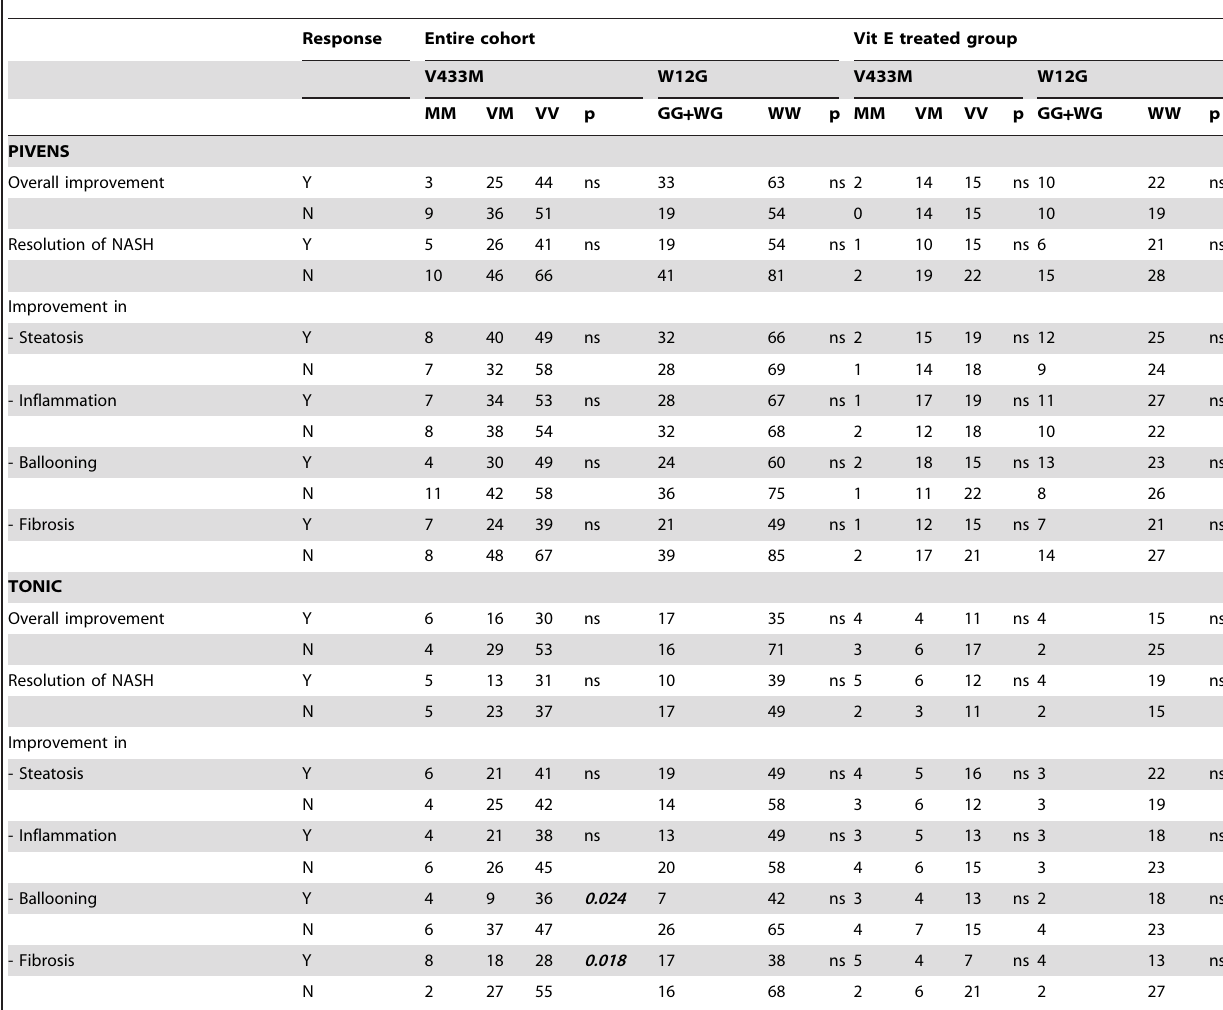
Table 4. Association between CYP4F2 polymorphisms and histological